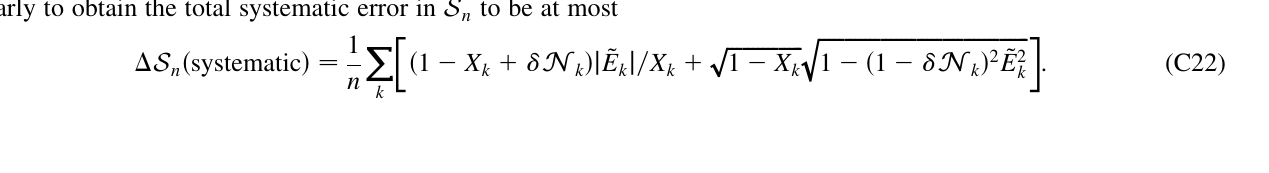
TABLE I. Size of error factors contributing to (cid:4) S n ð systematic Þ (Fig. 5 data) without 1-km fiber. n 1